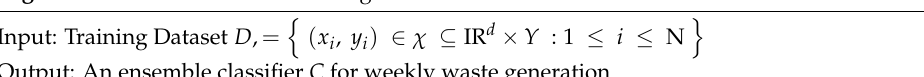
Algorithm 1. Pseudocode for training the meta classifier